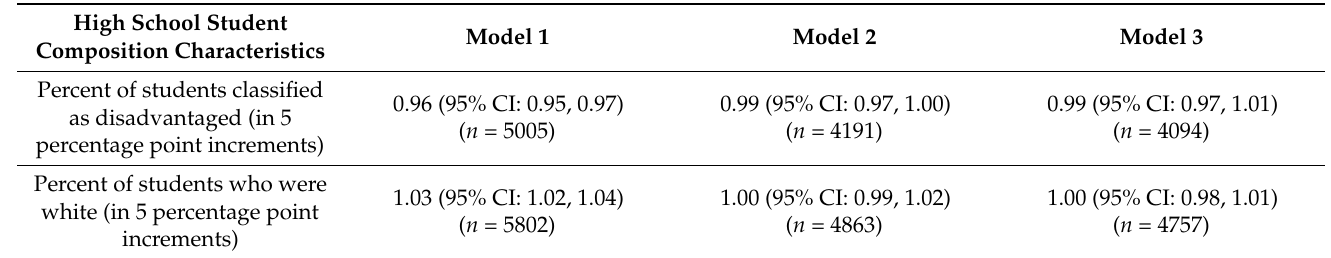
Table 2. Ordered odds ratios for self-rated health at age 40.